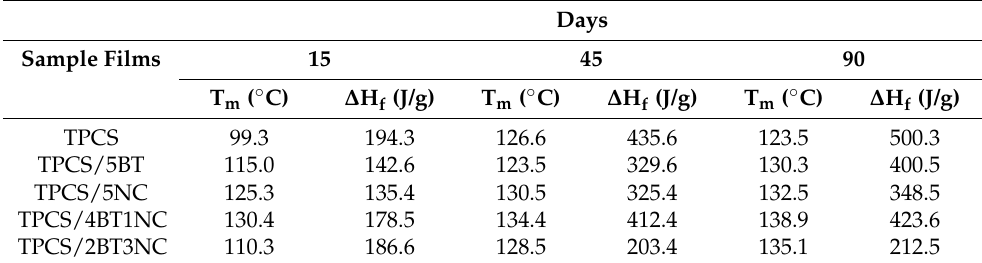
Table 2. Melting temperatures (Tm) and enthalpy of fusion ( ∆ Hf) for TPCS, TPCS-C, and TPCS-HC